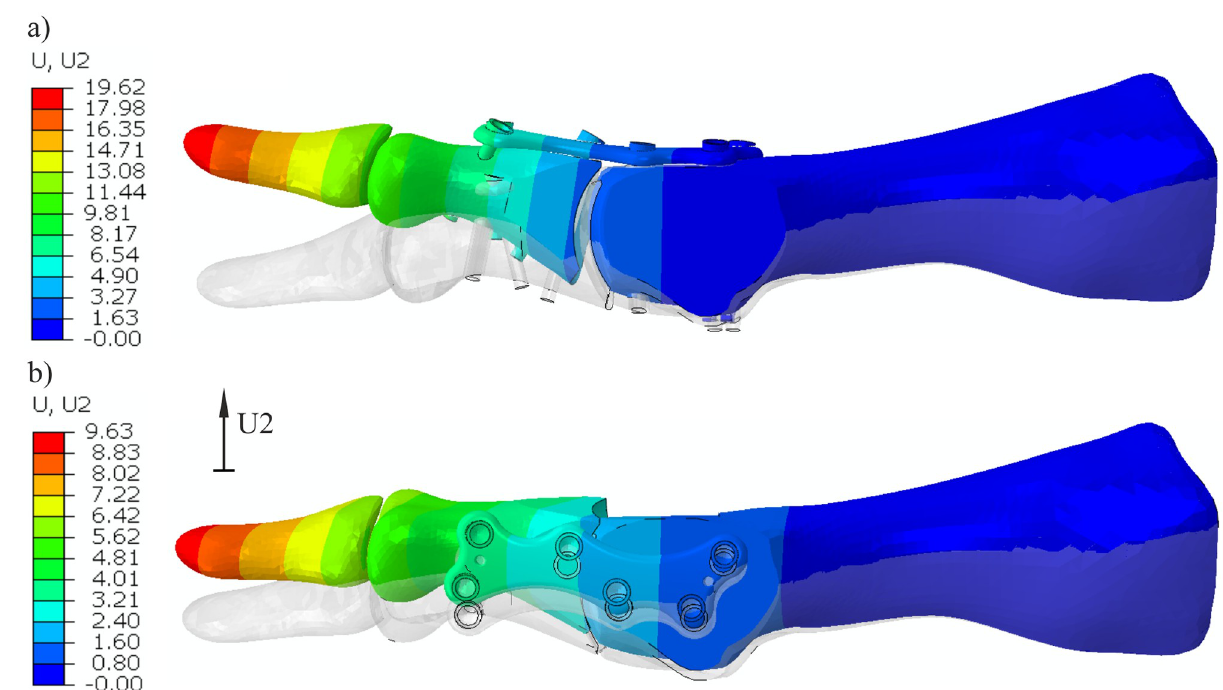
Fig 8. Dorsal displacements [mm] in the FEM analysis of models with a) a dorsal plate and b) a medial